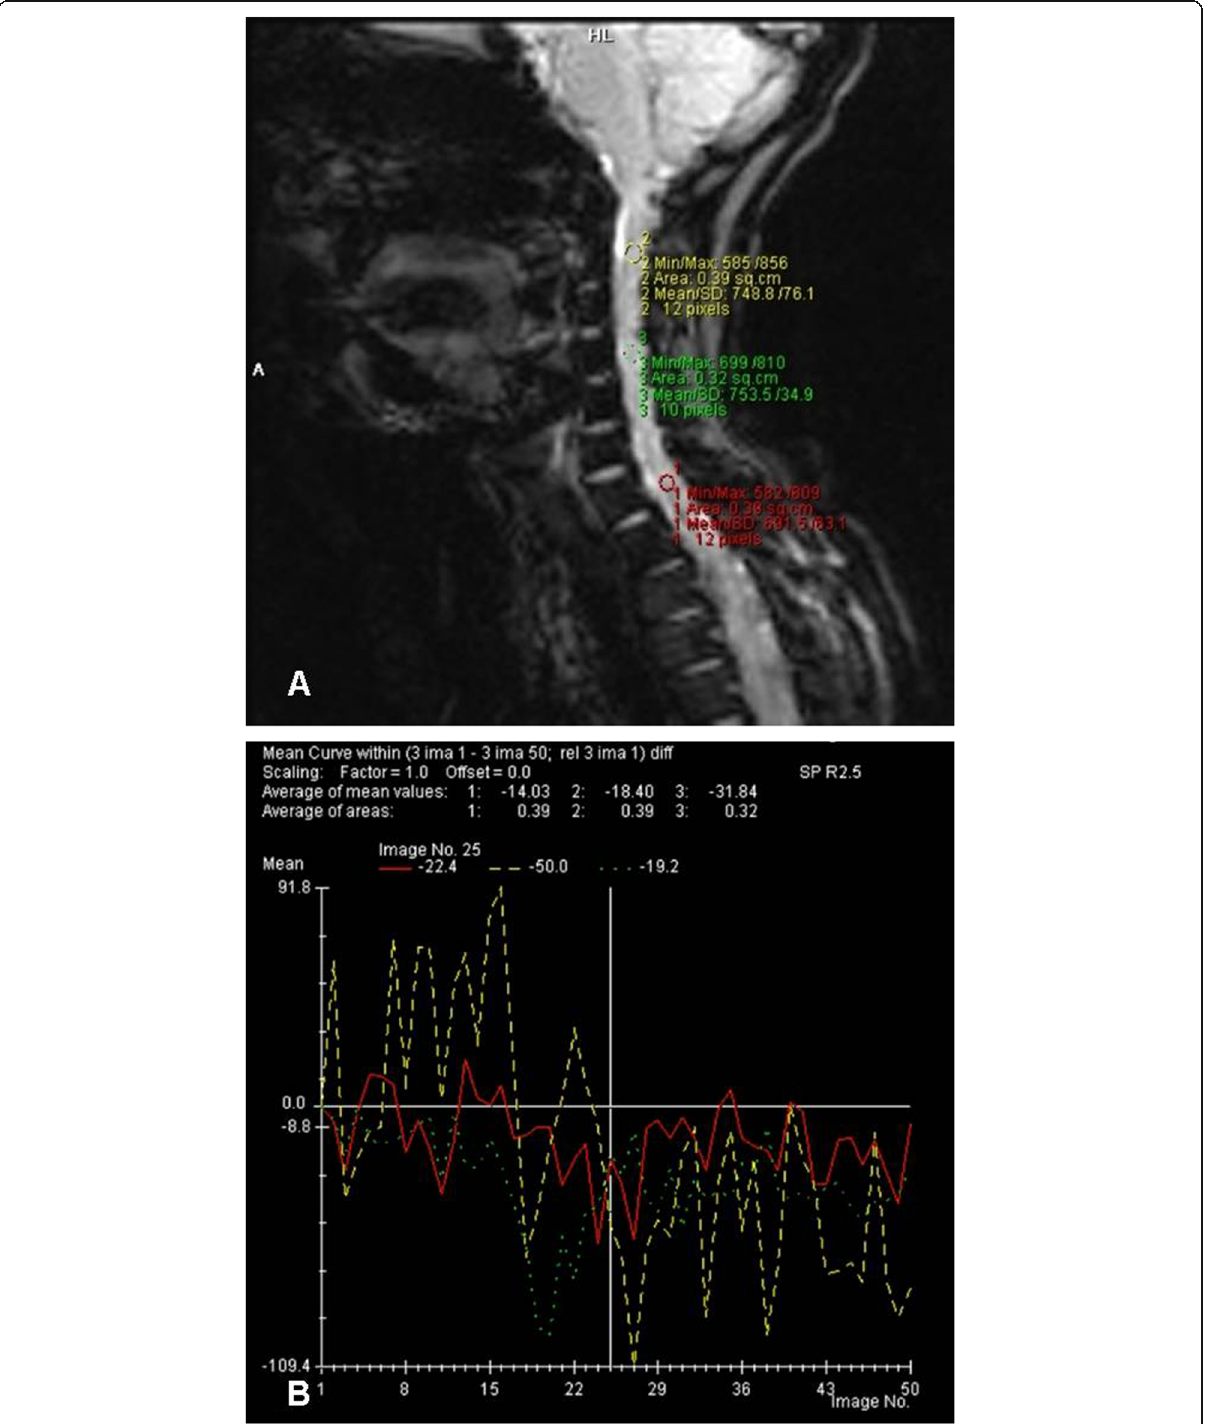
Fig. 5 Demonstration of how post processing assessment method was done by dedicated software. Perfusion mean curves were created by placement of the ROI on sagittal perfusion source ( a ) to create time intensity curves ( b